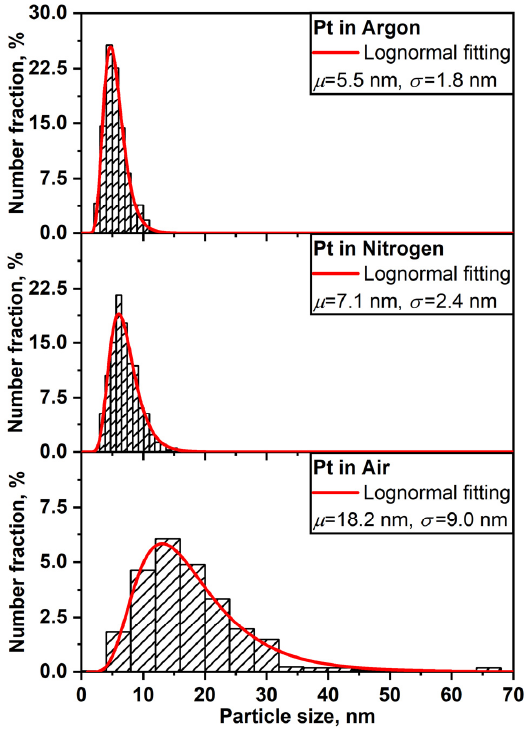
Figure 3. SEM images and EDX spectra of PtNPs synthesized by spark discharge under ( a ) Ar, ( b ) N 2 and ( c ) air.